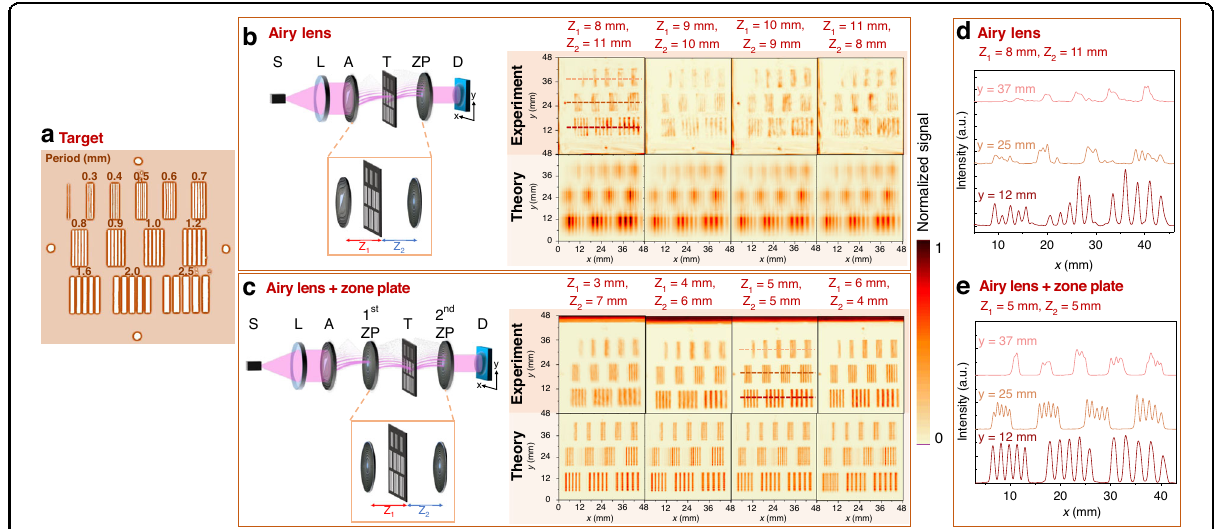
Fig. 3 Imaging of non-transparent sample using nonparaxial Airy beam. Image of the target with different period slits ( a ). Performance of the nonparaxial Airy phase mask in THz imaging in two setups: with a single nonparaxial zone plate ( b ) and two nonparaxial zone plates ( c ). T indicates the imaged target. The color bar is normalized to the maximal value of the signal. Z 1 and Z 2 indicate distances between optical elements and the object. The fi rst row on the right and the second row on the right present comparison of the experimentally obtained and numerically calculated object pictures for both setups, respectively. Cross-sections of the imaged objects (at positions denoted by dashed lines) are depicted in graphs ( d ) for setup with an Airy lens and a single nonparaxial zone plate and ( e ) for an Airy lens and two nonparaxial zone plates. Cross-sections of the recorded image ( d ) proving the 3.2 λ spacial resolution with more distorted target bars image; Cross-sections of the recorded image ( e ) with precise spatial frequency resolution reaching 1.6 λ with the contrast of 2